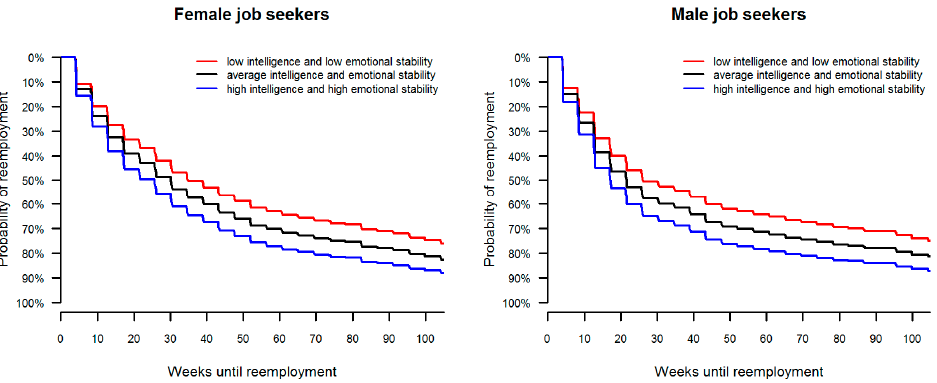
Figure 2. Estimated survival functions for time until reemployment by low ( M − 1 SD ) and high ( M + 1 SD ) crystallized intelligence and emotional stability for female and male job seekers.